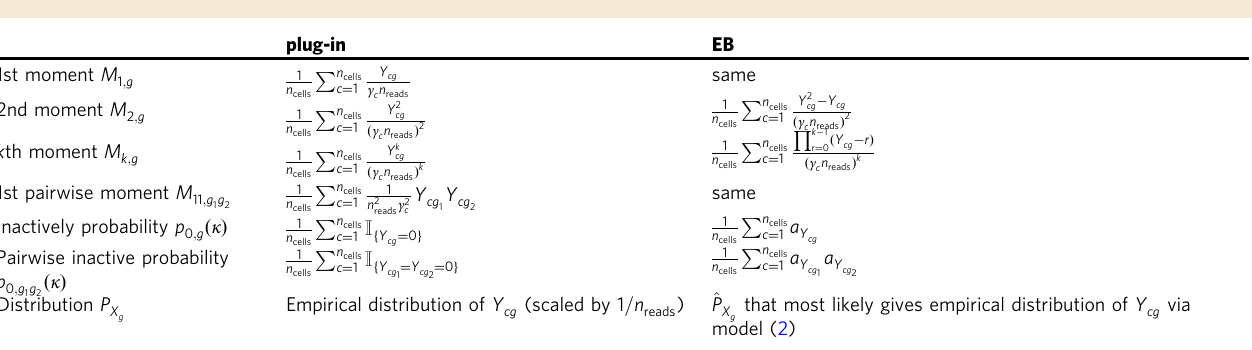
Table 1 Comparison of the plug-in estimator and the EB estimator.